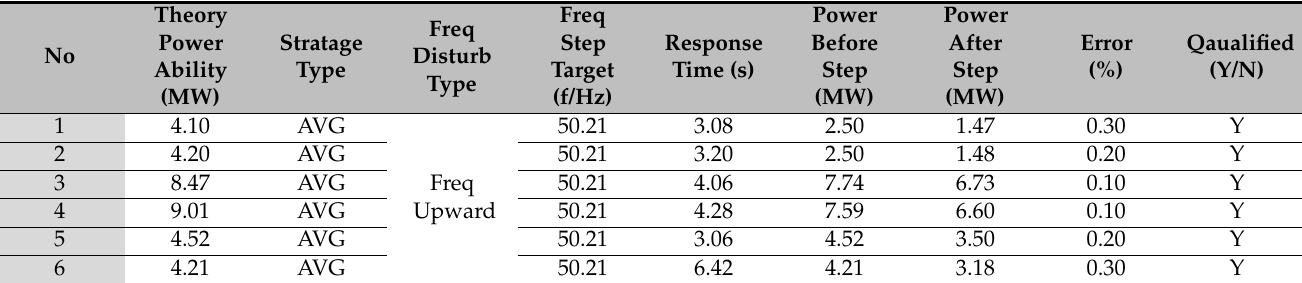
Table 2. Test Record of Different Distribution